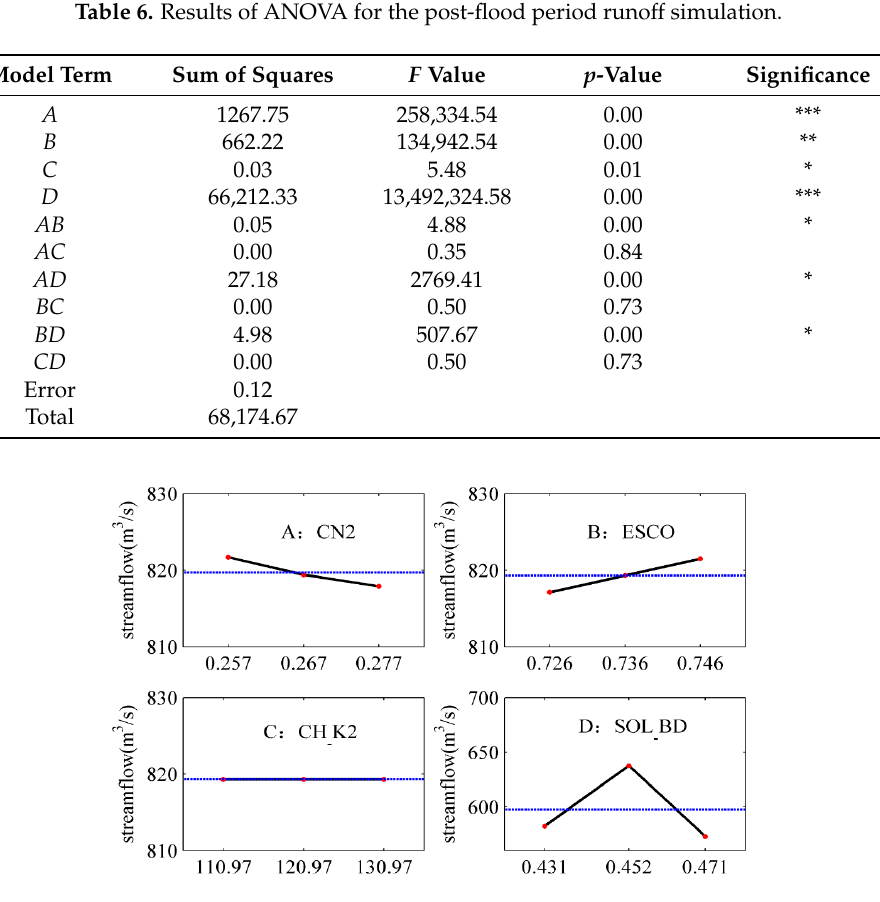
Table 6. Results of ANOVA for the post-flood period runoff simulation.